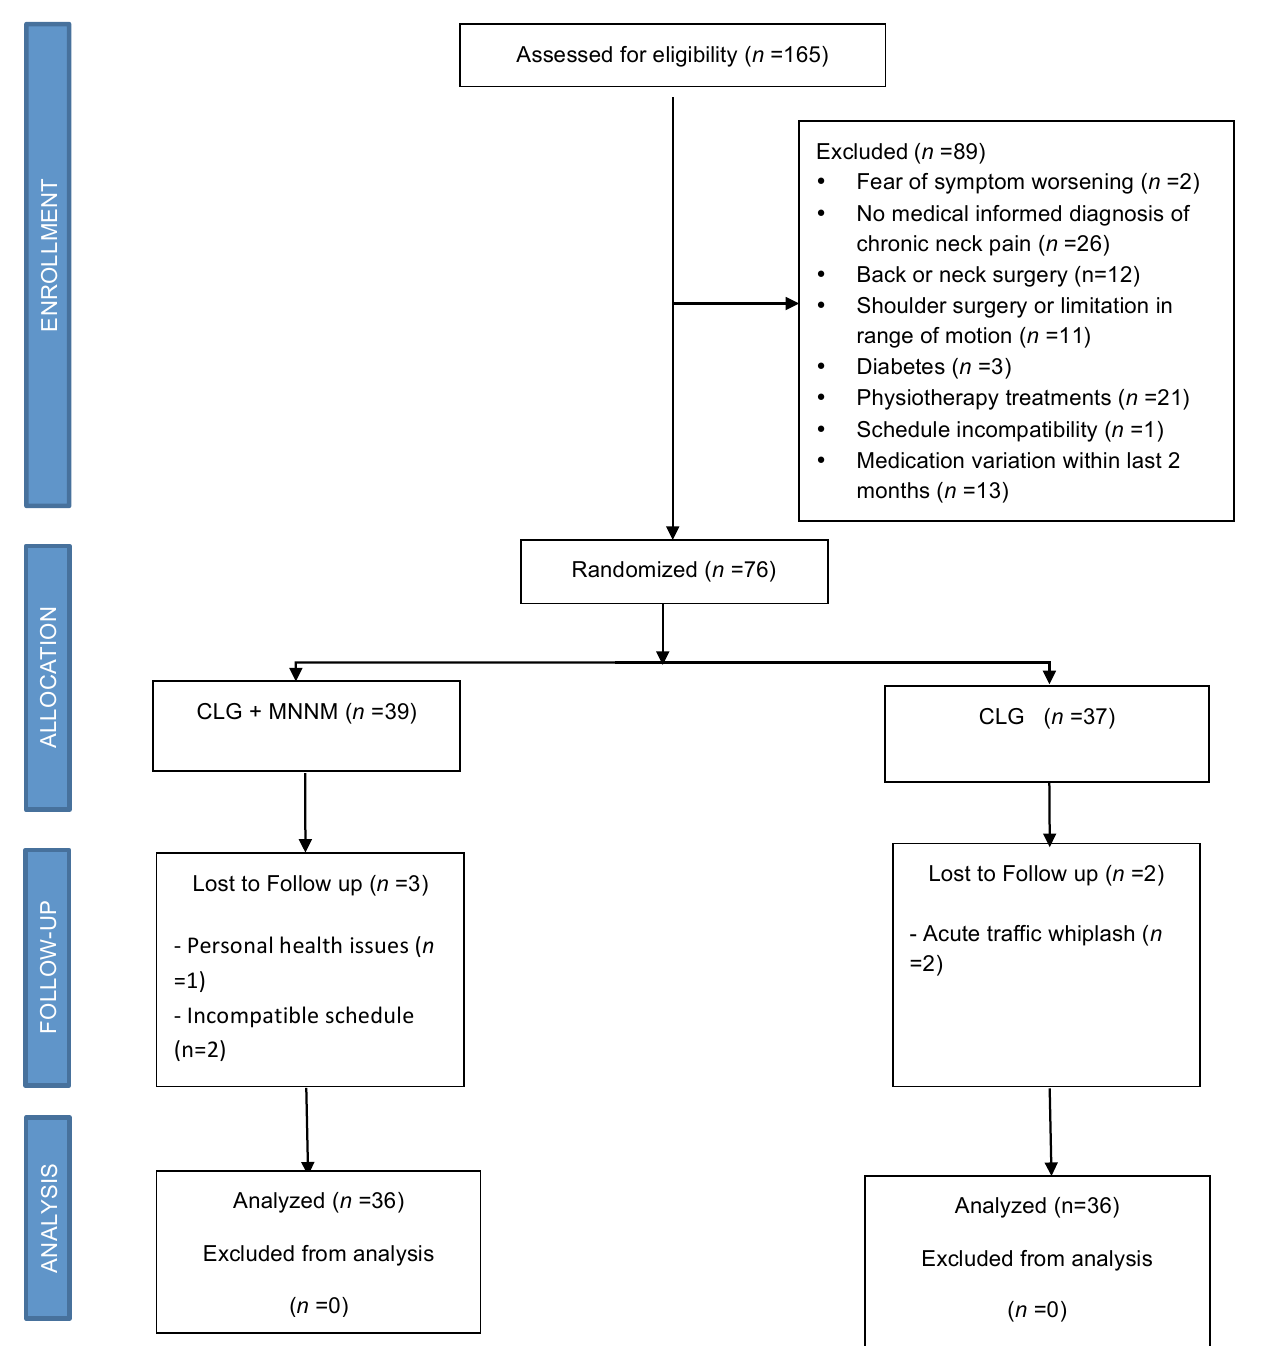
Figure 1. Consort Flow diagram